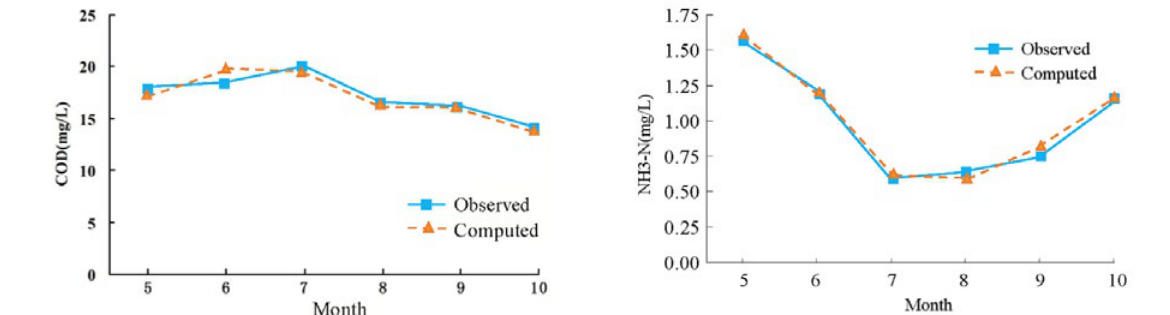
Fig. 7: Verification of NH 3 -N in Chenggaozi cross-sec (cid:415) on (2012)